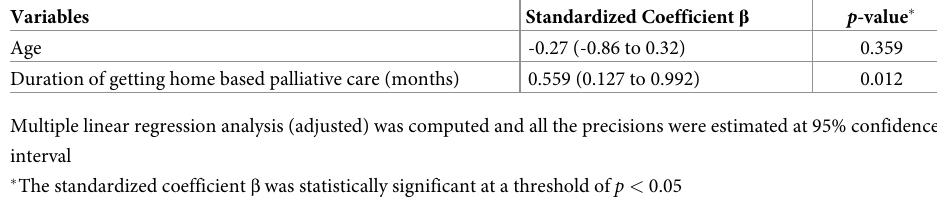
Table 7. Predictors of QoL among cancer patients (n = 51).